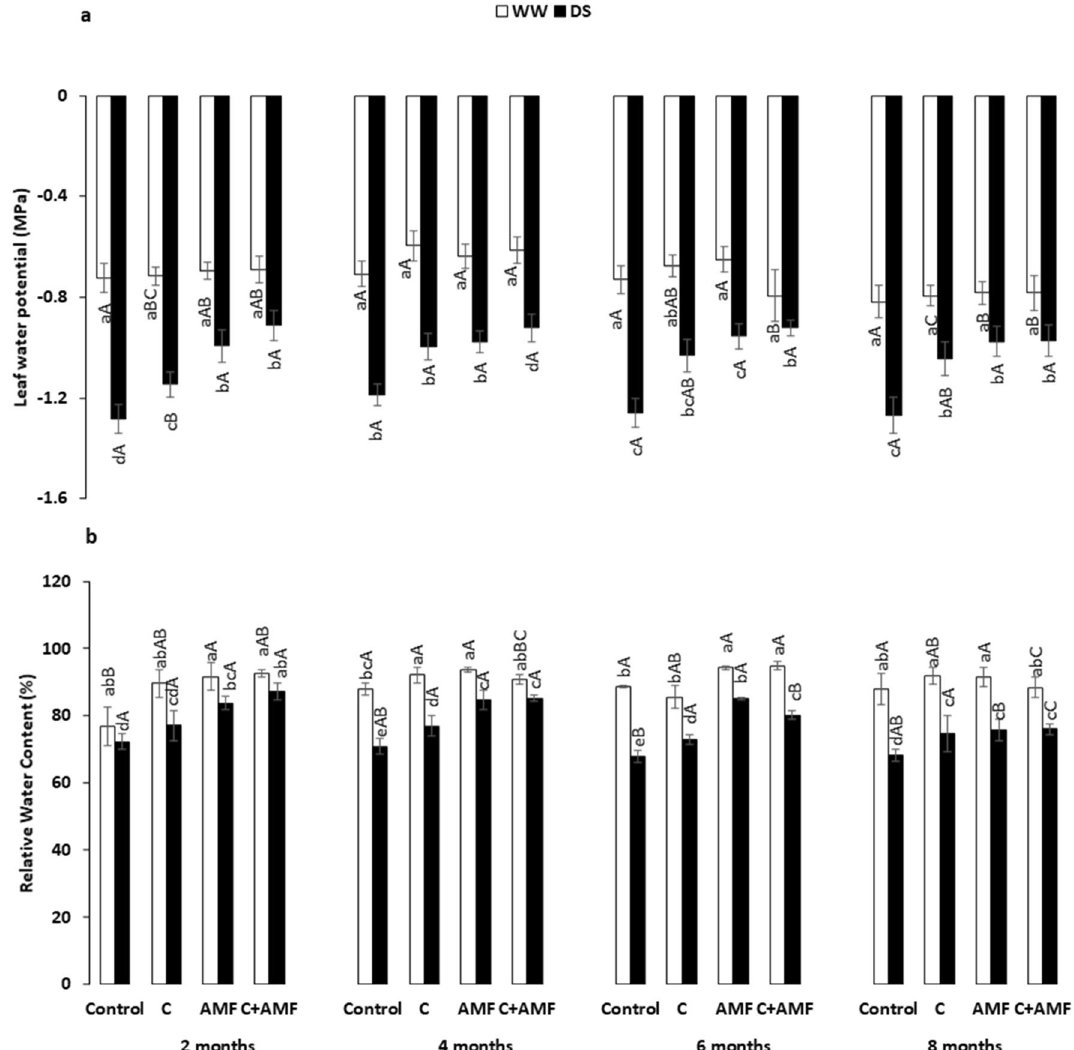
Figure 2. Influence of water regimes (WW: well-watered; open bars and DS: drought stress; filled bars) on ( a ) leaf water potential (Ψ Leaf ) and ( b ) relative water content (RWC) in control carob plants and plants amended with compost (C) and/or assemblage of indigenous arbuscular mycorrhizal fungi (AMF). Data are mean ± SE (n = 5). Means followed by the same letters within the same time point are not significantly different at P < 0.05 (Tukey’s HSD). The upper case represents the differences within WW or DS water regimes, and the lower case represents the differences within a one-time